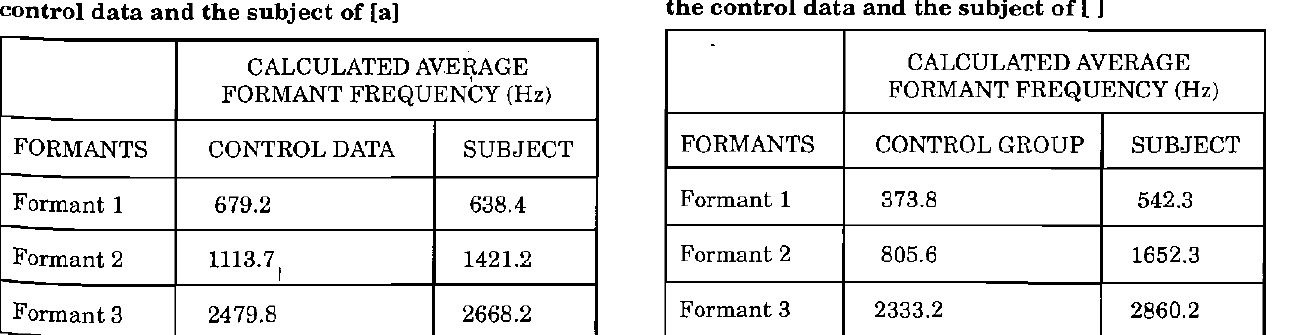
TABLE 10: Average formant frequencies (in Hz) of the control data and the subject of [